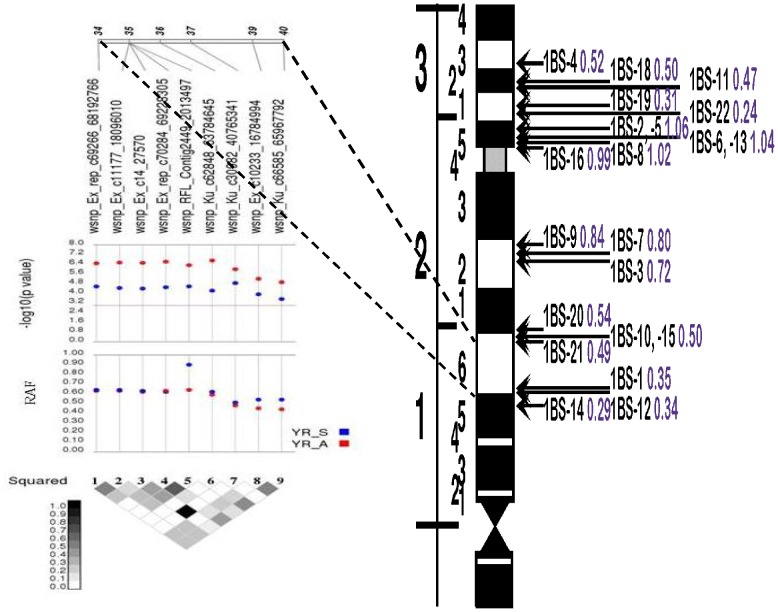
Haplotype block on chromosome 1BS comprising nine SNP markers significantly associated with Yr resistance at seedling and adult plant stage (left) aligned with 1BS physical map (right) based on the integrated mapping information (Saintenac et al 2013).